Question: What style of plot is this figure drawn as?
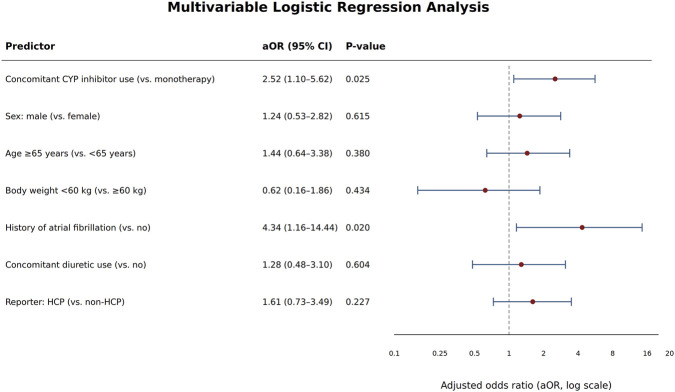
Answer: forest